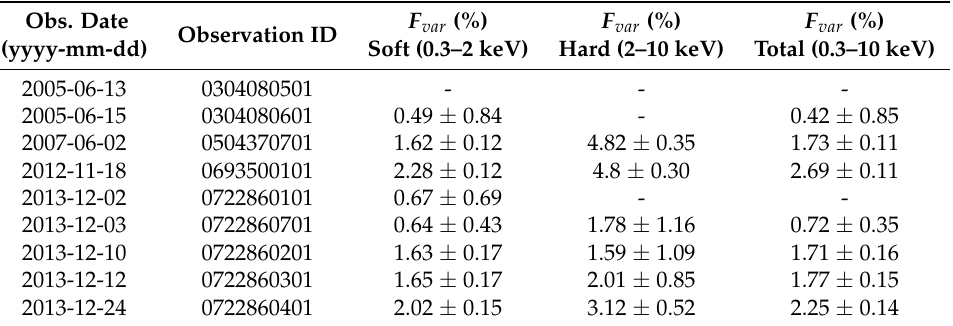
Table 2. X-ray variability parameter F var